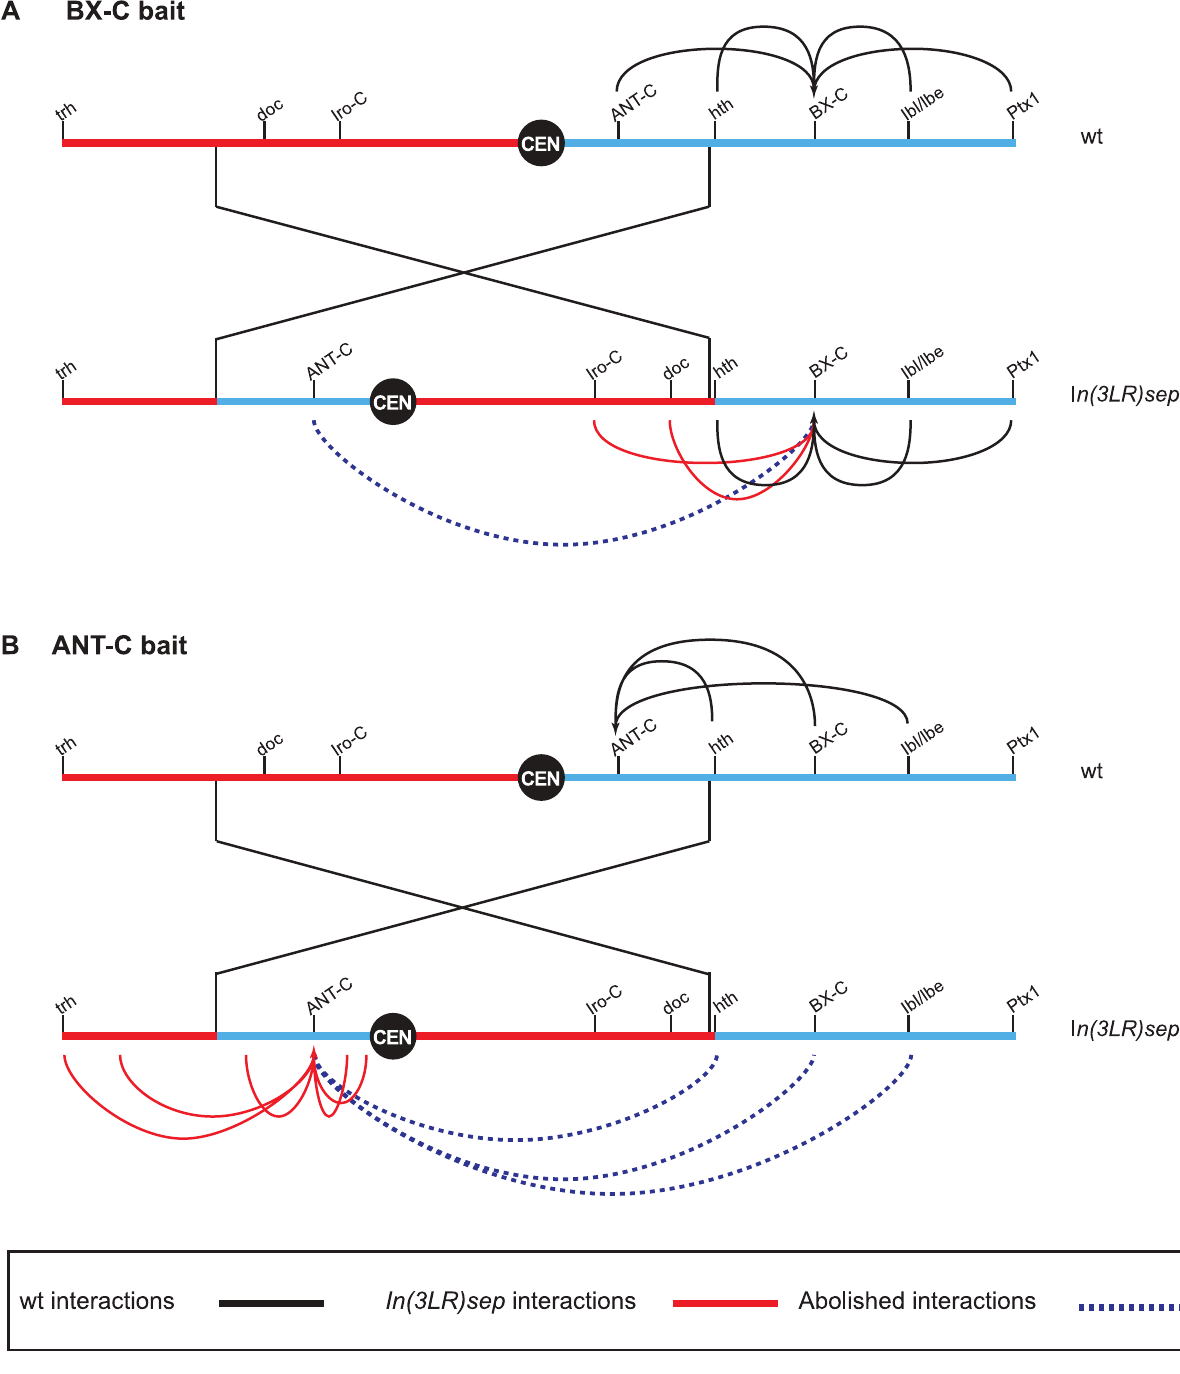
Figure 1. Chromatin interactions are constrained by chromosome arm architecture . (A) Depicting chromatin interactions when the homeotic gene cluster BX-C is used as bait in 4C studies. Inversion of chromosome 3 ( In(3LR)sep ) at specific breakpoints results in loss of contacts between the homeotic gene clusters. (B) Reciprocal experiments using ANT-C as bait show the extent to which new chromatin interactions can form within the same chromosome arm, but are prevented across chromosome arms.